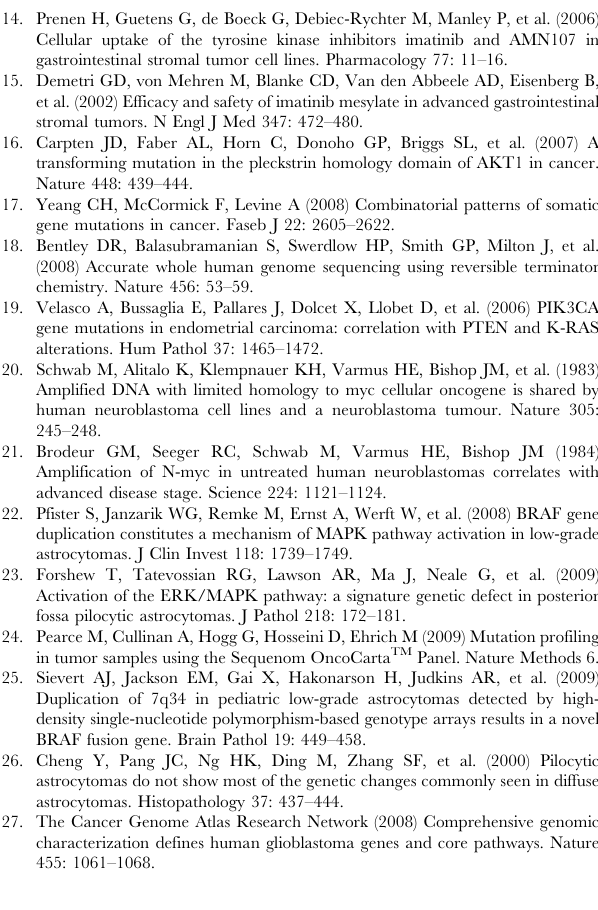
Figure S1 Performance of OncoMap in fresh frozen and FFPE- derived DNA. Receiver operator characteristic curves (ROCs) are plotted for fresh frozen (left panel) and FFPE-derived (right panel) DNAs, against unidirectional OncoMap KRAS assays, using Illumina data as a truth-set (see Methods